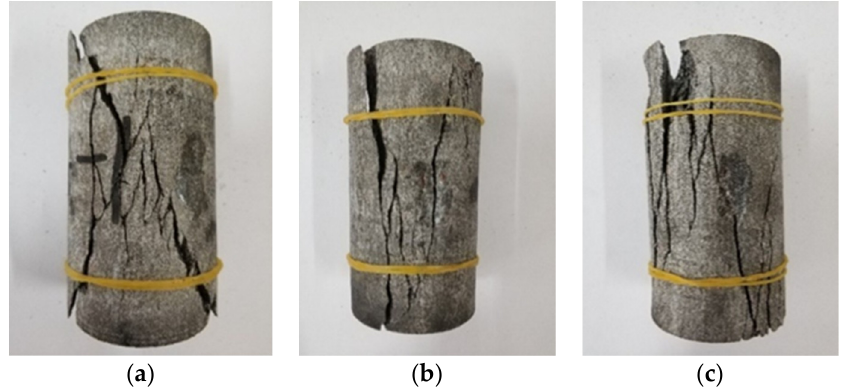
Figure 6. Specimen form of gneiss in the high geostress area. ( a ) G-1. ( b ) G-2. ( c ) G-3.